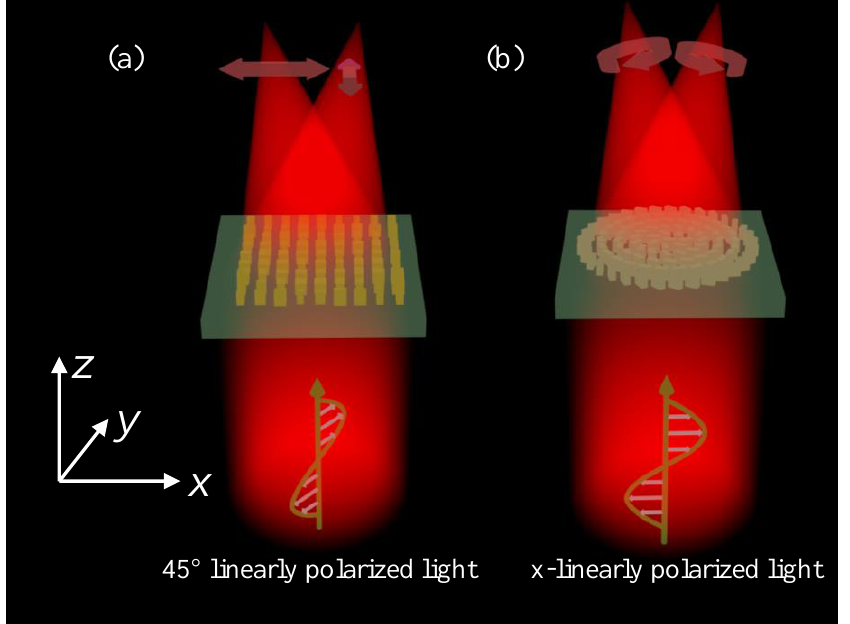
Figure 1. Schematic of the ( a ) orthogonal linear polarization multiplexing metalens and ( b ) orthogonal circular polarization multiplexing metalens.